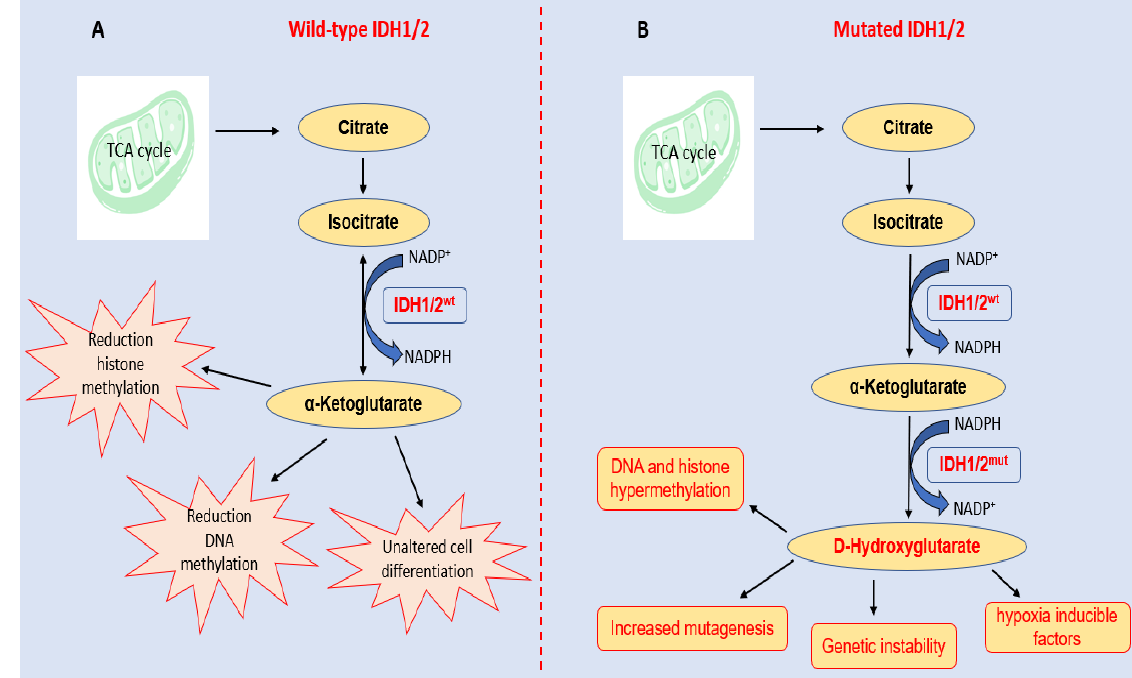
Figure 2. Parallel diagrams of IDH1/2 ′ s biological roles in ( A ) normal cellular functions and ( B ) the consequence of its neomorphic activity acquired upon hot-spot mutations. ( A ) Wild-type enzymes promote normal cellular processes through metabolic pathways and the activity of α -ketoglutarate. ( B ) Mutant enzymes (IDH1/2 mut ) produce the oncometabolite D-hydroxyglutarate, a potent inhibitor of α -ketoglutarate-dependent dioxygenases, with the concomitant depletion of the NADPH, resulting in an aberrant activation of signaling pathways and sustaining cancer initiation and progression.